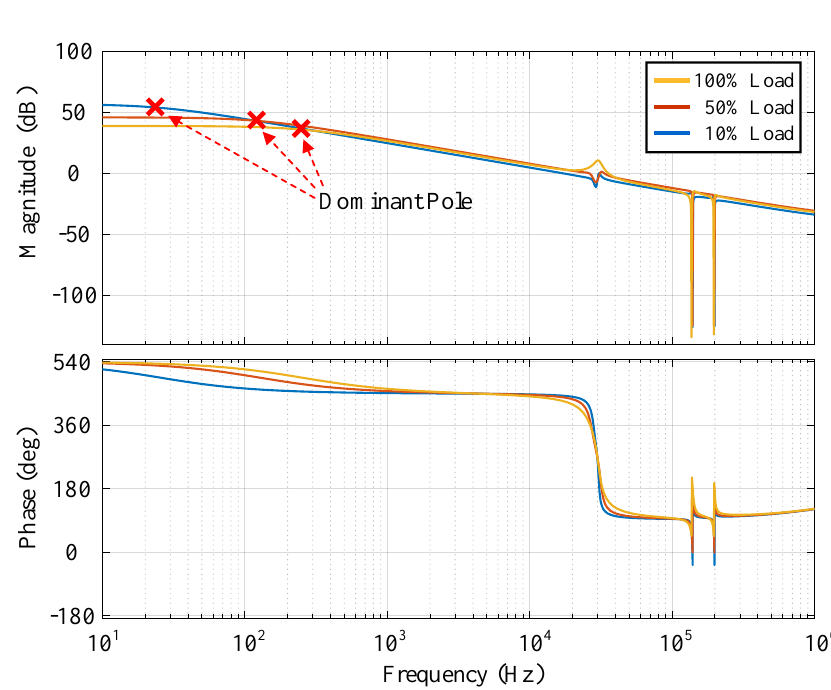
Figure 9. Open loop bode plot of duty ratio-to-output voltage transfer function under various load conditions.